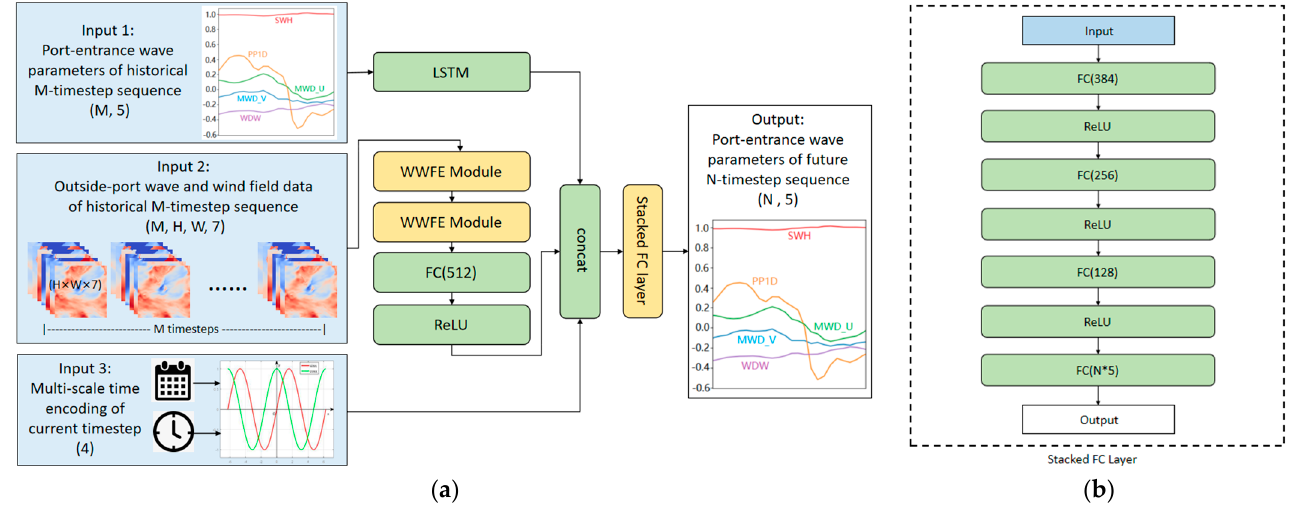
Figure 5. PWP-out structure diagram, where ( a ) is the overall structure and ( b ) is the stacked FC layer of ( a ).